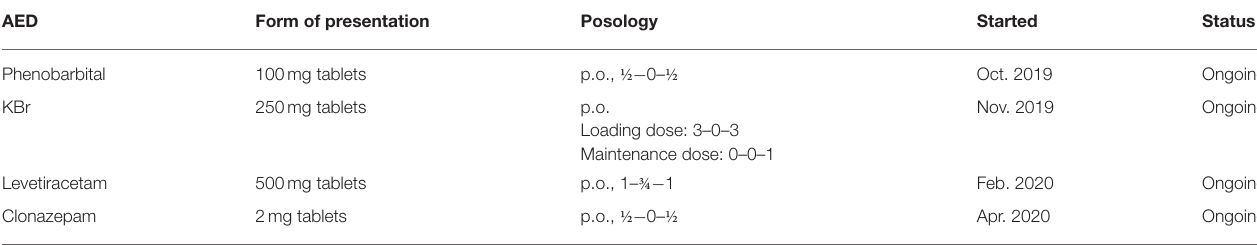
TABLE 2 | Treatment protocol of Case No.